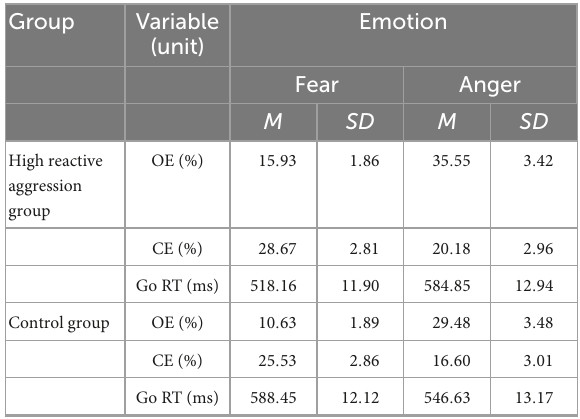
expressions) × Inhibition (Go, No-Go) × Electrode (F3, Fz, F4, FC3, FCz, and FC4 for N2 and FC3, FCz, FC4, C3, Cz, and C4 for P3) repeated-measures ANOVA was performed for the stimulus-locked N2 and P3 amplitudes. To analyze the No-Go N2 effect and No-Go P3 effect more clearly, the Go amplitude was subtracted directly from the No-Go amplitudes on each emotion condition at each electrode. A Group (high reactive aggression group, control group) × Emotion (fearful expressions, angry expressions) × Electrode (F3, Fz, F4, FC3, FCz, and FC4 for N2 and FC3, FCz, FC4, C3, Cz, and C4